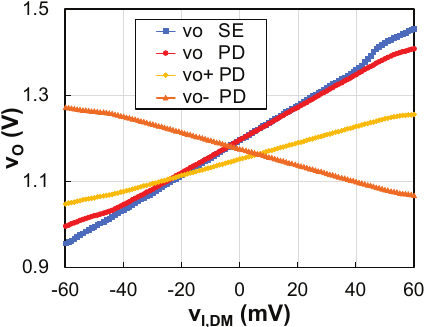
Figure 8. v O vs. v I , DM DC transfer characteristics.